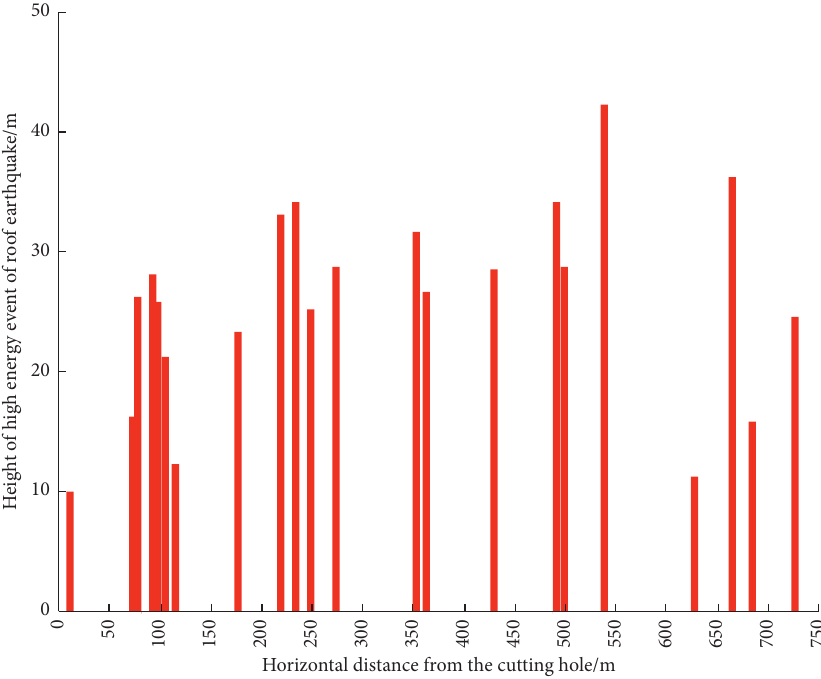
Figure 12: Statistical data of the heights of high energy mining earthquakes.